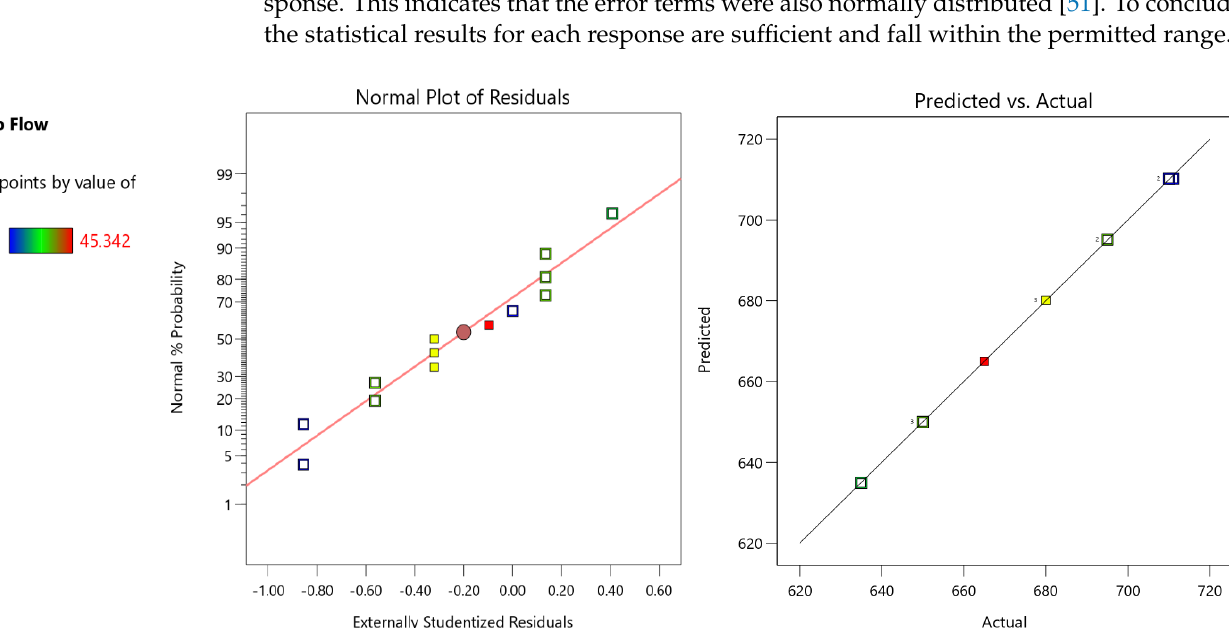
Figure 15. Normal plot for residuals, and actual vs. predicted values for compressive strength.